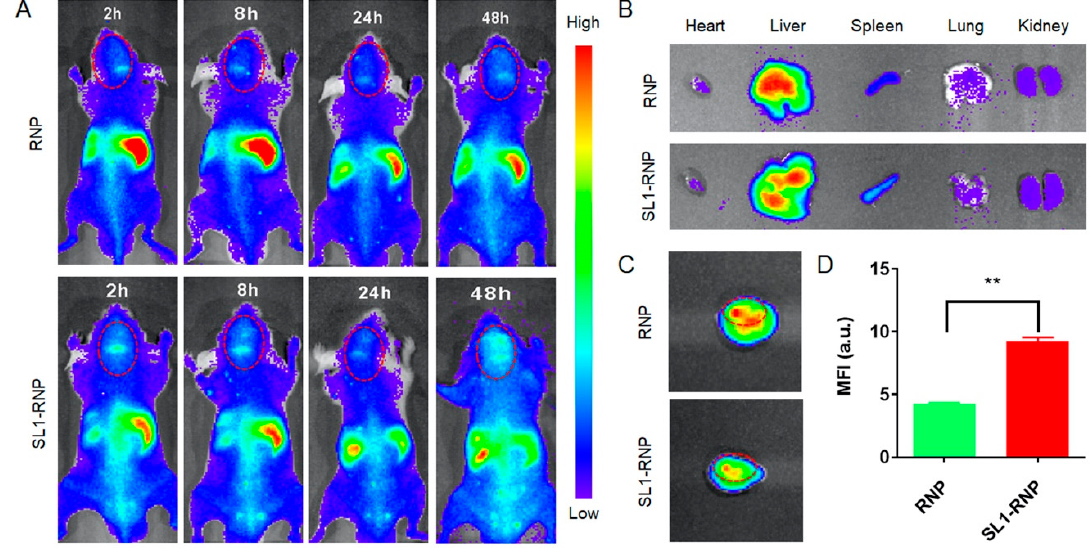
Figure 5. Targeting property of SL1 − RNP in vivo. ( A ) In vivo fluorescence imaging of glioblastoma- bearing nude mice administrated with DiR − labelled SL1 − RNP or RNP, respectively. Ex vivo fluorescence imaging of major organs ( B ) and brains ( C ) collected 48 h after intravenous injection. ( D ) The fluorescence intensity of brains at 48 h after intravenous injection ( n = 4). ** p < 0.01.